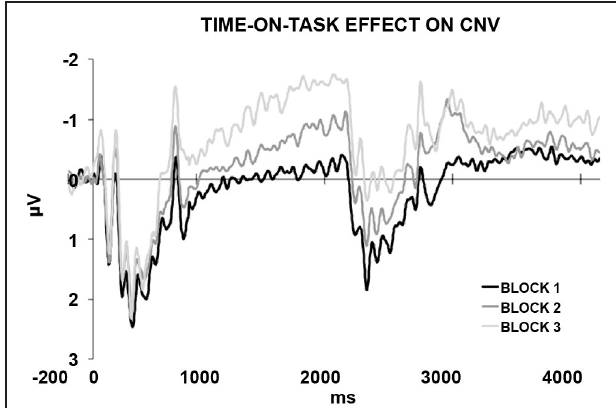
FIGURE 2 | The passive CNV. The generation of a temporal S1–S2 contingency rule instantiates an automatic temporal expectancy. This in turn results in the elicitation of a passive CNV peaking at the expected S2 time point, corresponding to approximately 2000 ms from the onset of the stimulus, that is, S1 (500 ms) + standard ISI (1500 ms). The standard ISI-related ERP activity is plotted separately for the first, second, and third block. The progressive increases in amplitude and steepness reveals a time-on-task effect. This suggests that participants learnt the temporal structure progressively, discovering the temporal contingency between S1 and S2 on a trial-by-trial